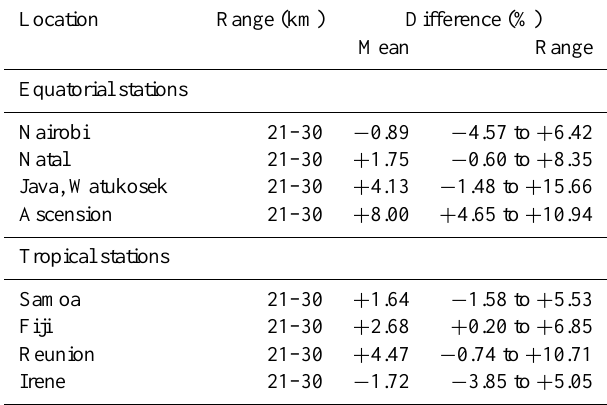
Table 2. Summary of results for the GOMOS comparison with SHADOZ. For each station: the vertical range used to calculate the median difference, mean value and minimum/maximum values in this range are